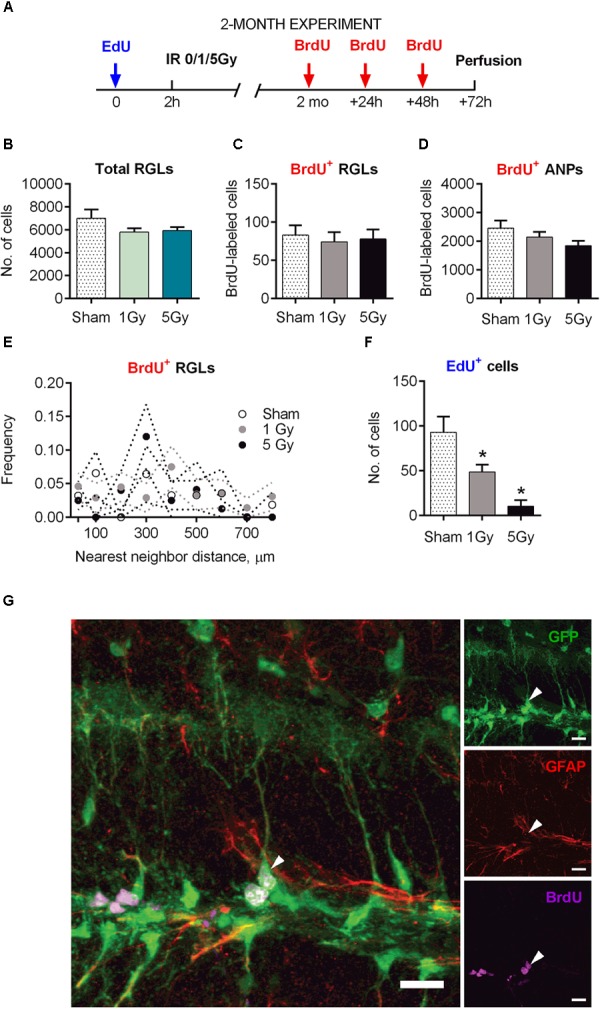
Maintenance of early and late progenitor cells at 2 months post-exposure to 0, 1, or 5 Gy (2-month experiment). (A) Experimental design. (B) Total RGLs (dividing and non-dividing). (C) Dividing (BrdU+) RGLs. (D) Dividing (BrdU+) ANPs. (E) Frequencies of nearest neighbor distances between BrdU-labeled RGLs. The frequencies were estimated as the number of cell pairs at particular distance bins per total number of BrdU+ RGLs. The dots and dotted lines represent mean frequencies and SEM ranges. (F) Survival of cells labeled with EdU at 2 h before the exposure. ∗p < 0.05, a comparison with sham group, Dunnett’s multiple comparison test after one-way ANOVA, multiple t-tests with Holm–Sidak multiple comparison method for EdU+ cells in (F) (see Supplementary Table S2 for detailed statistics). N = 7 mice were used in 0 Gy group, n = 9 in 1 Gy group, and n = 7 in 5 Gy group. Bars show means and standard errors. (G) Examples of a labeled RGL (arrowhead) surrounded by ANPs. Scale bar shows 20 μm.